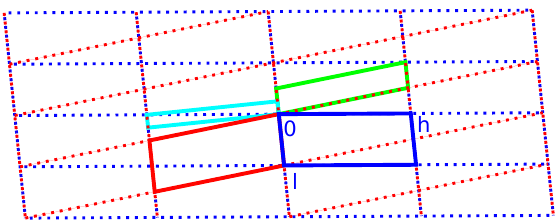
Figure 9. Reciprocal lattice of the unit cell as described in Table 2, viewed in the h 0 l plane. Blue and red indicate the individual unit cells ( P 2 1 / n setting). Green and cyan respectively indicate monoclinic-P and orthorhombic-C twin supercells. The blue and red lattices are derived from the monoclinic superlattice (see Scheme